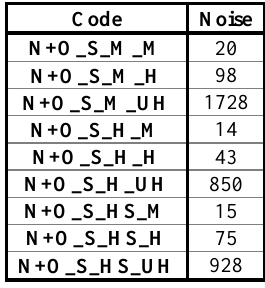
Table 5. Noise estimation in case of dense point cloud for nadiral+oblique configurations